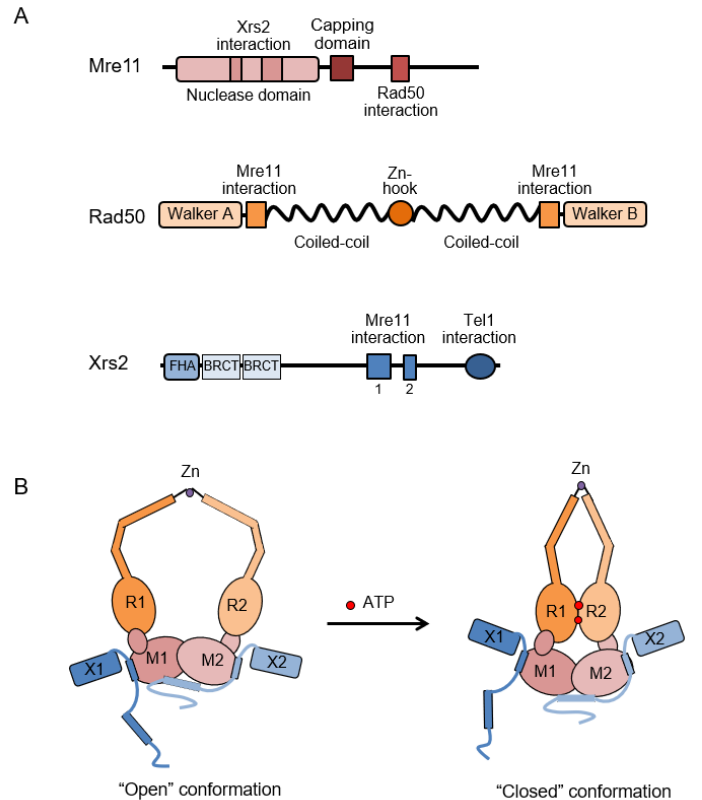
Figure 3. Domains and architecture of the MRX complex. ( A ) Mre11 consists a conserved phosphodiesterase nuclease domain and a capping domain at the N-terminus. The hydrophobic interaction domain for Rad50 resides towards the C-terminal region. Rad50 consists a bipartite ABC-ATPase domain at the N and C termini separated by two long coiled-coil domains and a zinc hook CxxC motif. Xrs2 harbors forkhead-associated (FHA) and BRCA1 C terminus (BRCT)